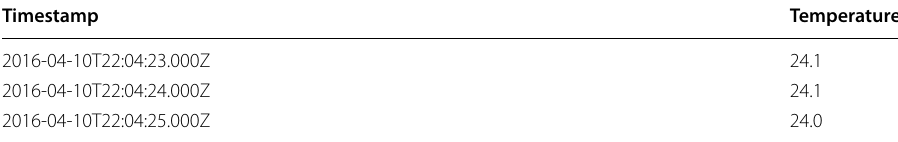
Table 5 TimeSeries data storage in a traditional RDBMS